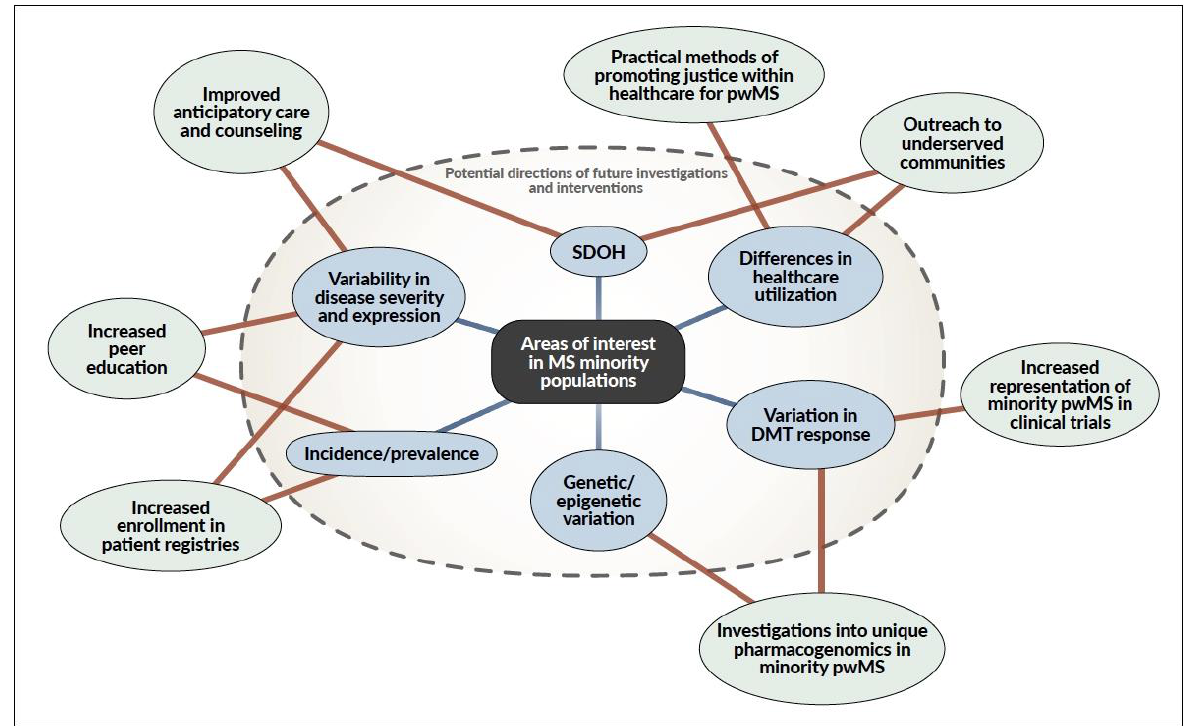
Figure 1. Areas of emphasis in care of minority populations with multiple sclerosis and future directions. The diagram illustrates points of emphasis emerging from a review of literature on multiple sclerosis (MS) in minority populations, specifically Hispanic and Black persons with multiple sclerosis (pwMS). Items beyond the dashed line indicate areas of future research and practice strategy changes.